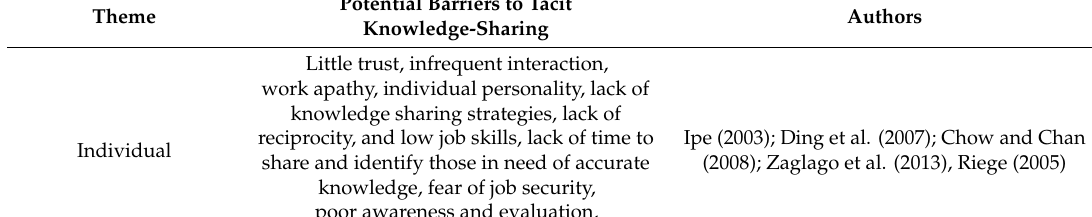
Table 1. A summary of potential barriers to tacit knowledge-sharing. Adapted from: Olaniran [38]. Potential Barriers to Tacit Theme Knowledge-Sharing